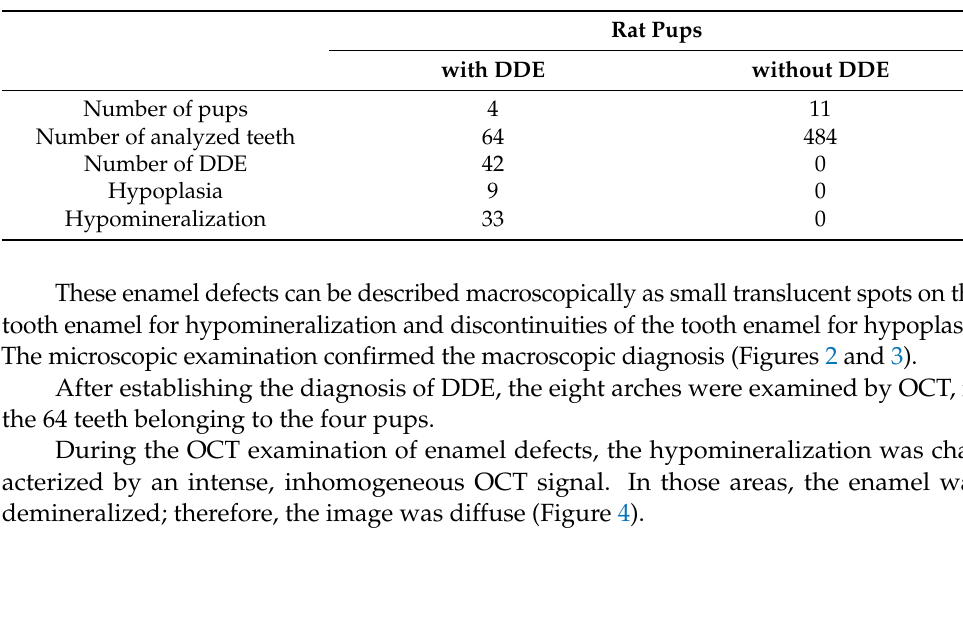
Table 1. Distribution of our study lot, according to DDE